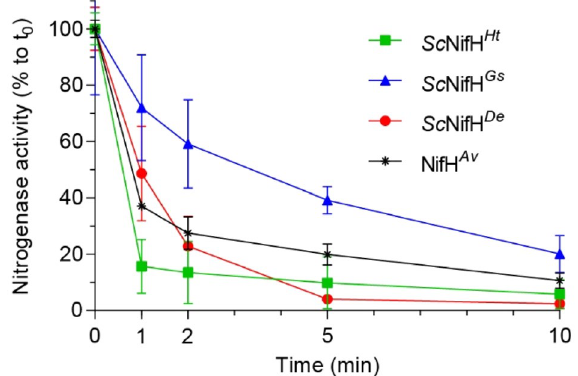
Figure 5. Sensitivity of Sc NifH Xx variants to O 2 . Nitrogenase activity of Sc NifH Ht (green squares), Sc NifH Gs (blue triangles) and Sc NifH De (red dots) was measured by ARA upon exposure to oxygen. NifH Av was used as NifH control protein (black stars). The molar ratio of NifH:NifDK Av was 40:1. Nitrogenase activity is shown in relation to the activity obtained prior to oxygen exposure at t 0 (for Sc NifH Ht 532 ± 30 units (nmol ethylene formed per min and mg of NifDK Av ), for Sc NifH Gs 159 ± 37 units, for Sc NifH De 188 ± 14 units and for NifH Av 1673 ± 51 units). Mean and SD is shown. n = 5 or 6 technical